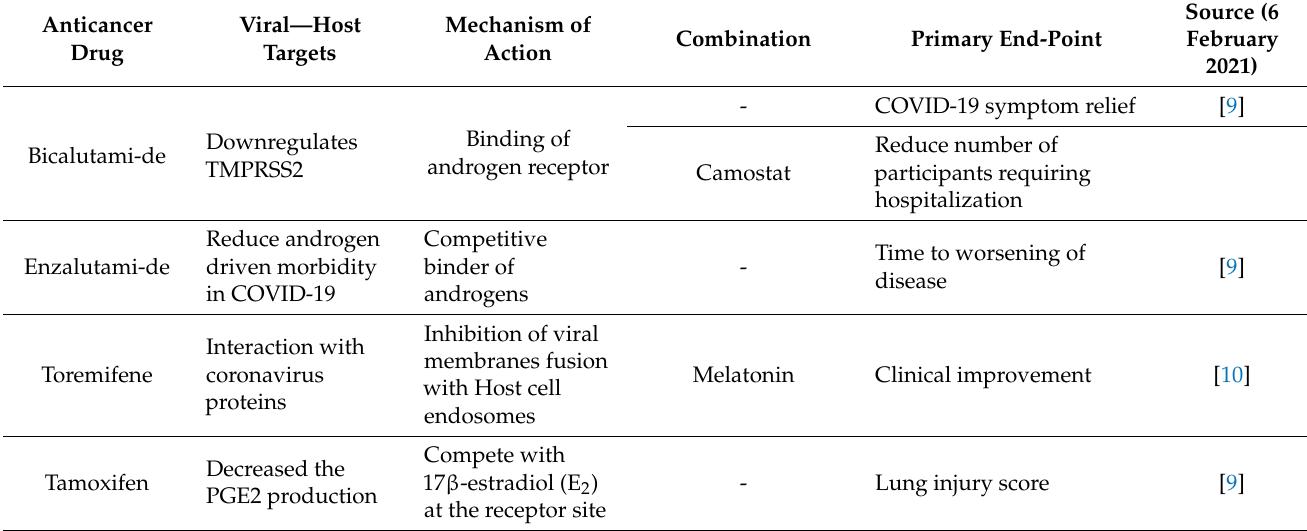
Table 4. Anticancer drugs in clinical trials for COVID-19: Hormone